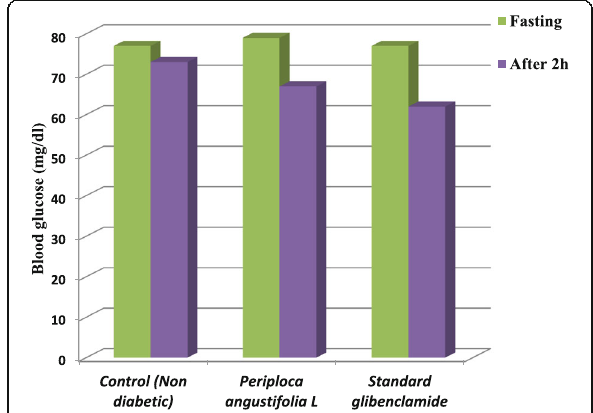
Fig. 6 Hypoglycemic activity of Periploca angustifolia L extract in non-diabetic rats (n =